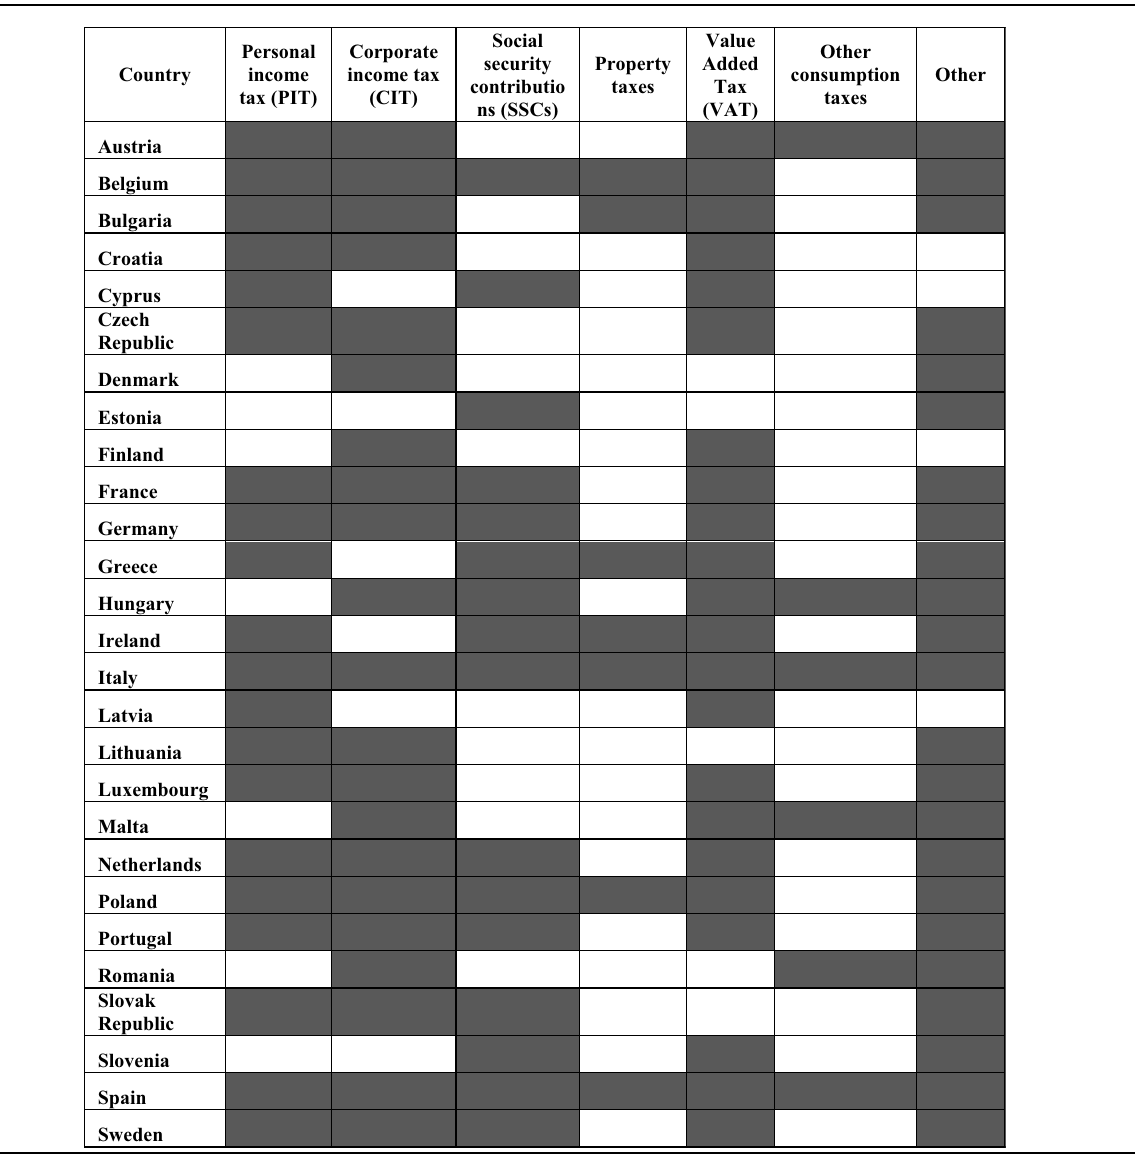
Table 3: Tax policy measures in EU, by tax type